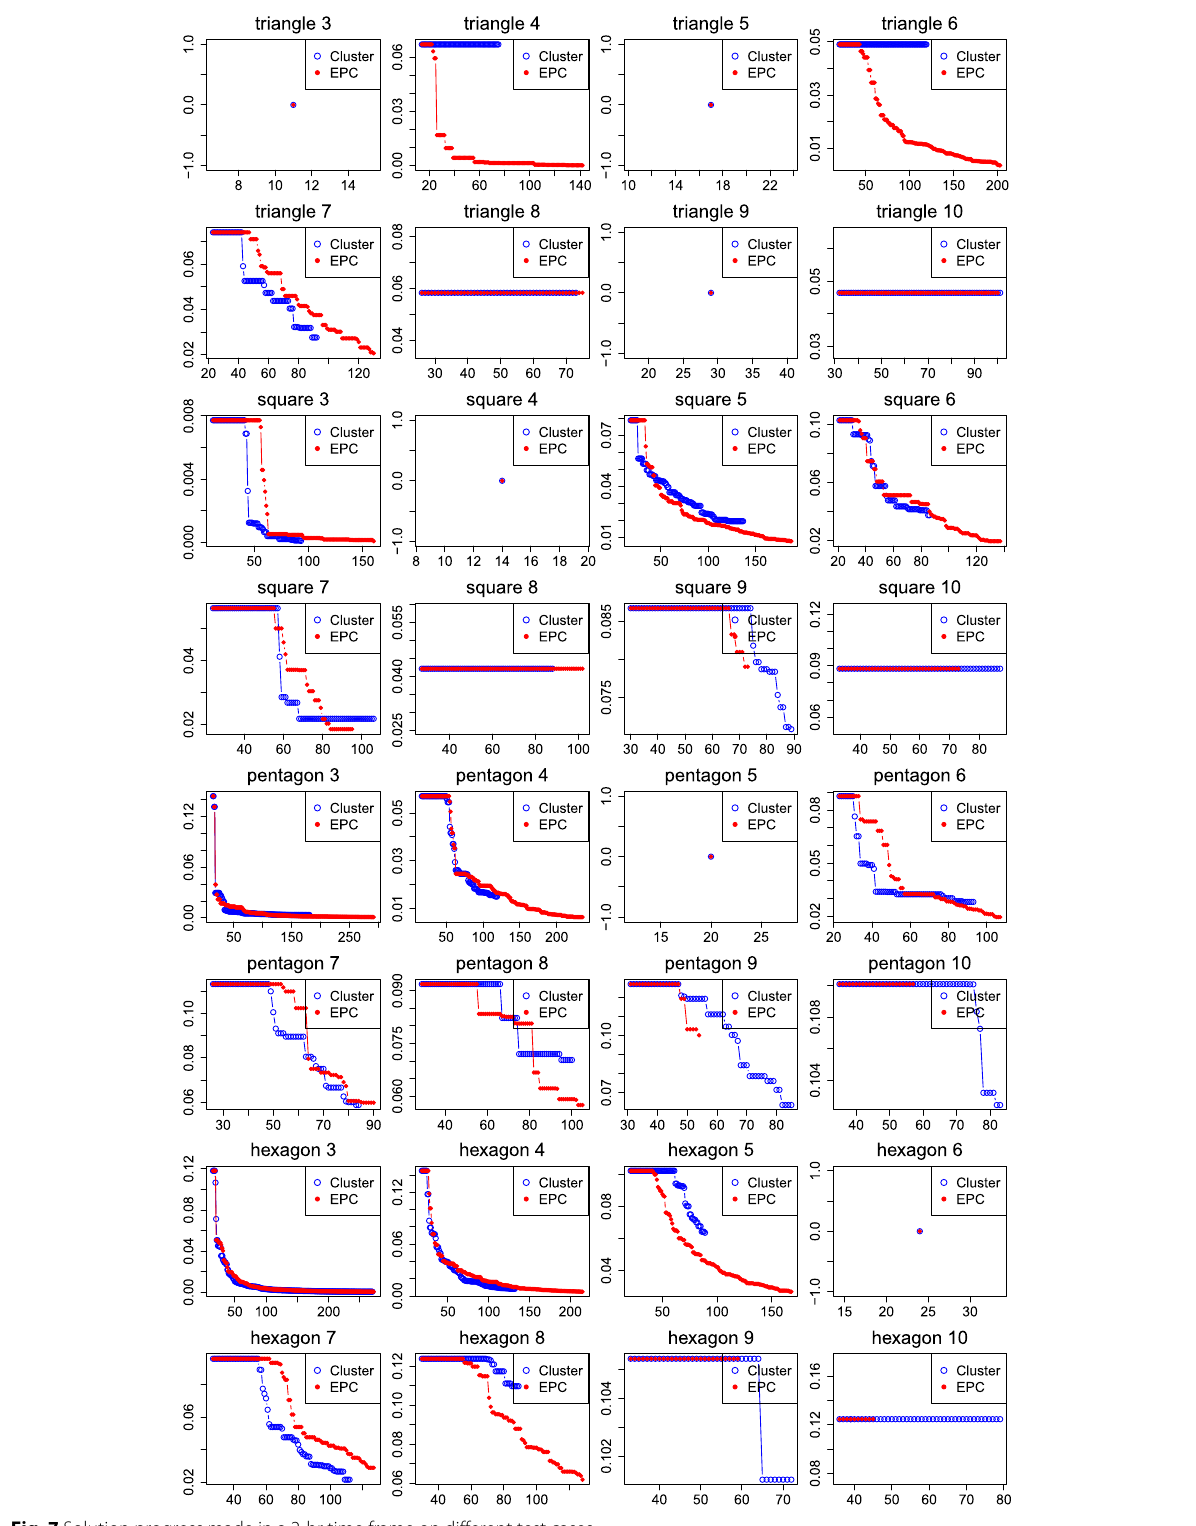
Fig. 7 Solution progress made in a 2-hr time frame on different test